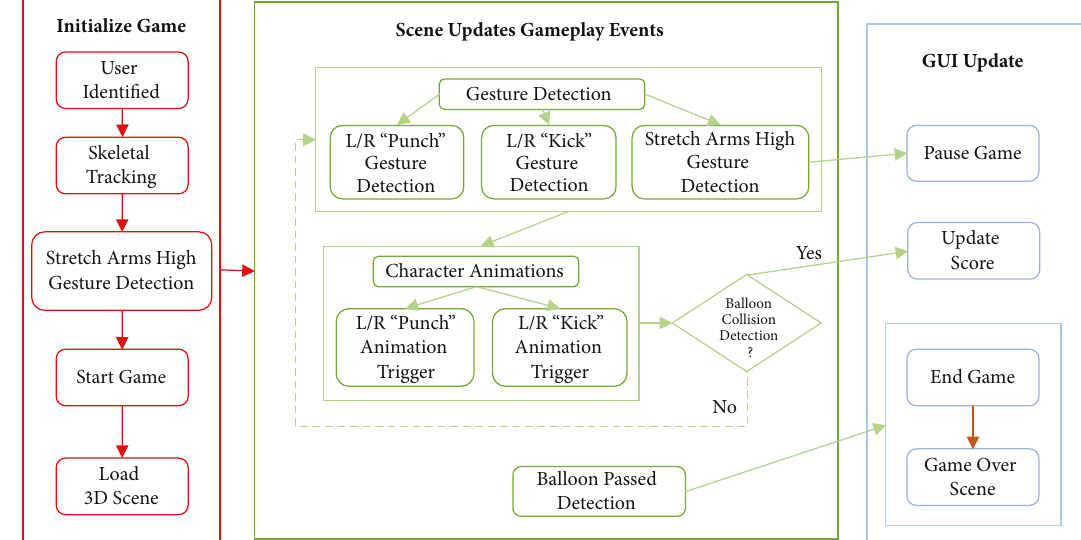
Figure 6: Functional diagram for the Balloon Goon game logic.